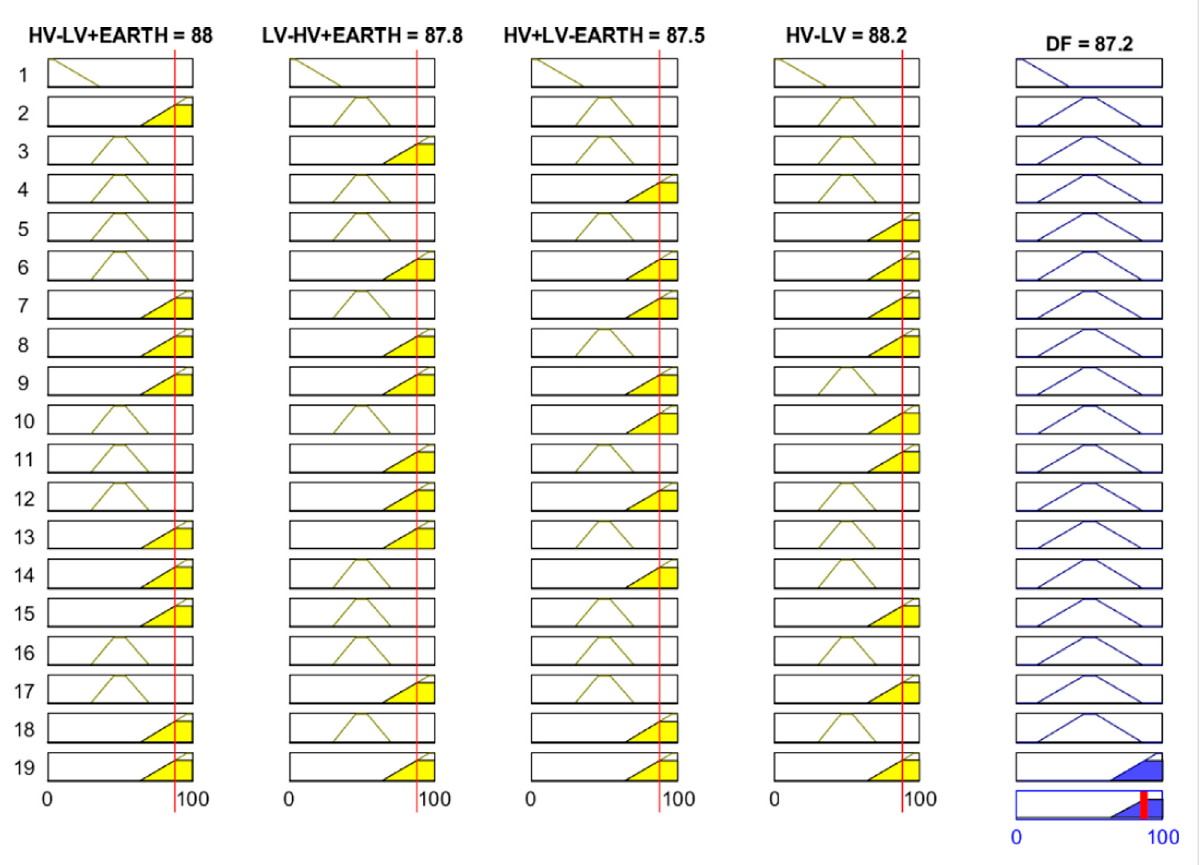
FIGURE 14 Rules used in fuzzy sublogic for dissipation factor of the insulation